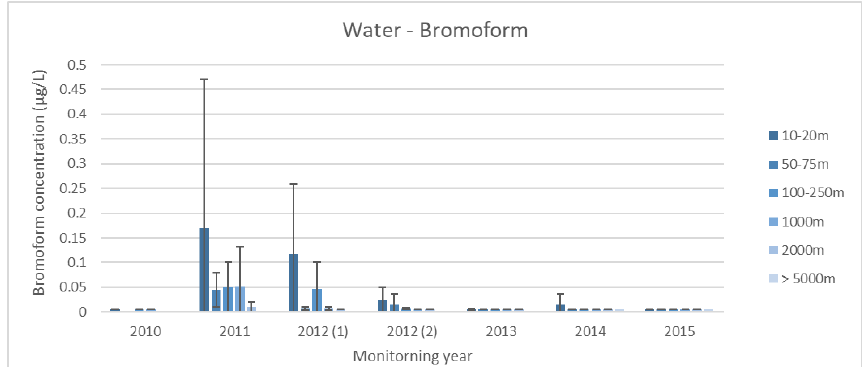
Table 1. Seawater concentration ratios (SWCRs) for bromoform resulted during monitoring activi- ties of an LNG terminal in the Northern Adriatic Sea. (1) July, (2) September, nc = not calculated